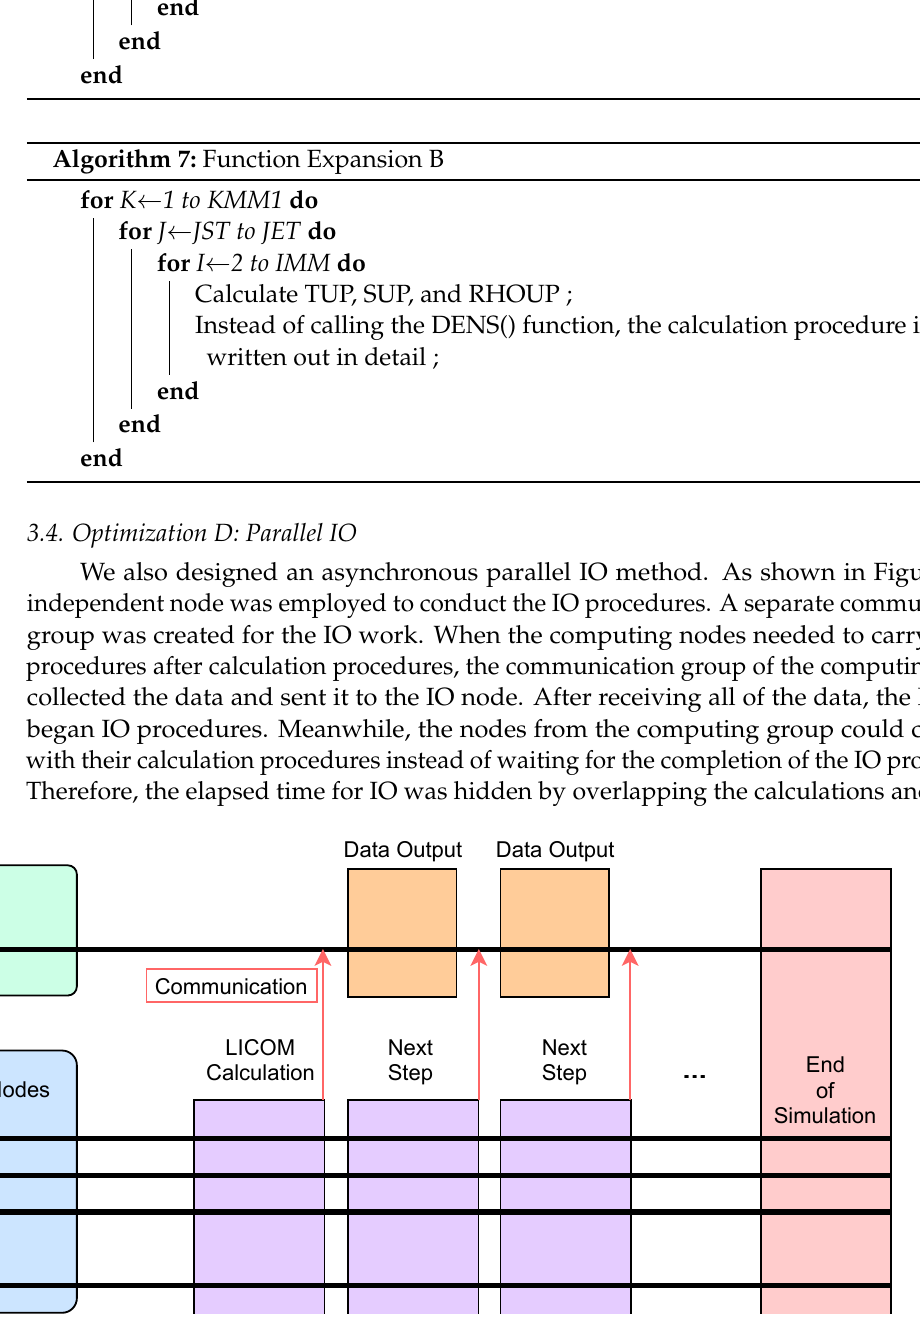
Figure 5. Asynchronous parallel